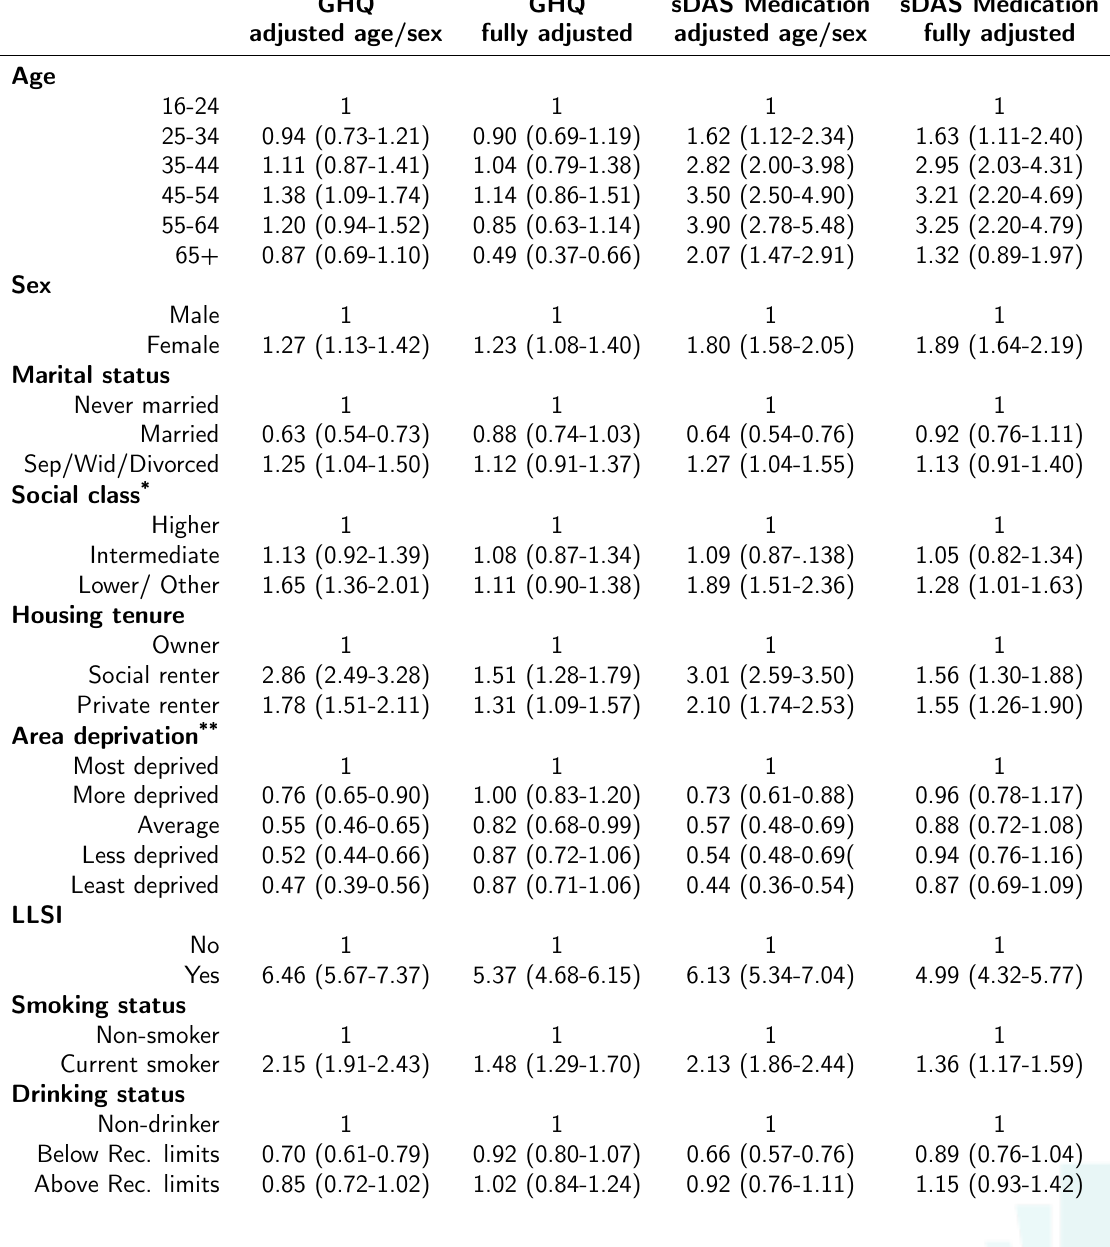
Table 2: A comparison of the characteristics of those presenting as cases against non-cases, as defined by (i) GHQ-12 only and (ii) assessment using sDAS medication only. Data represent Odds Ratios and 95% Confidence Intervals from logistic regression